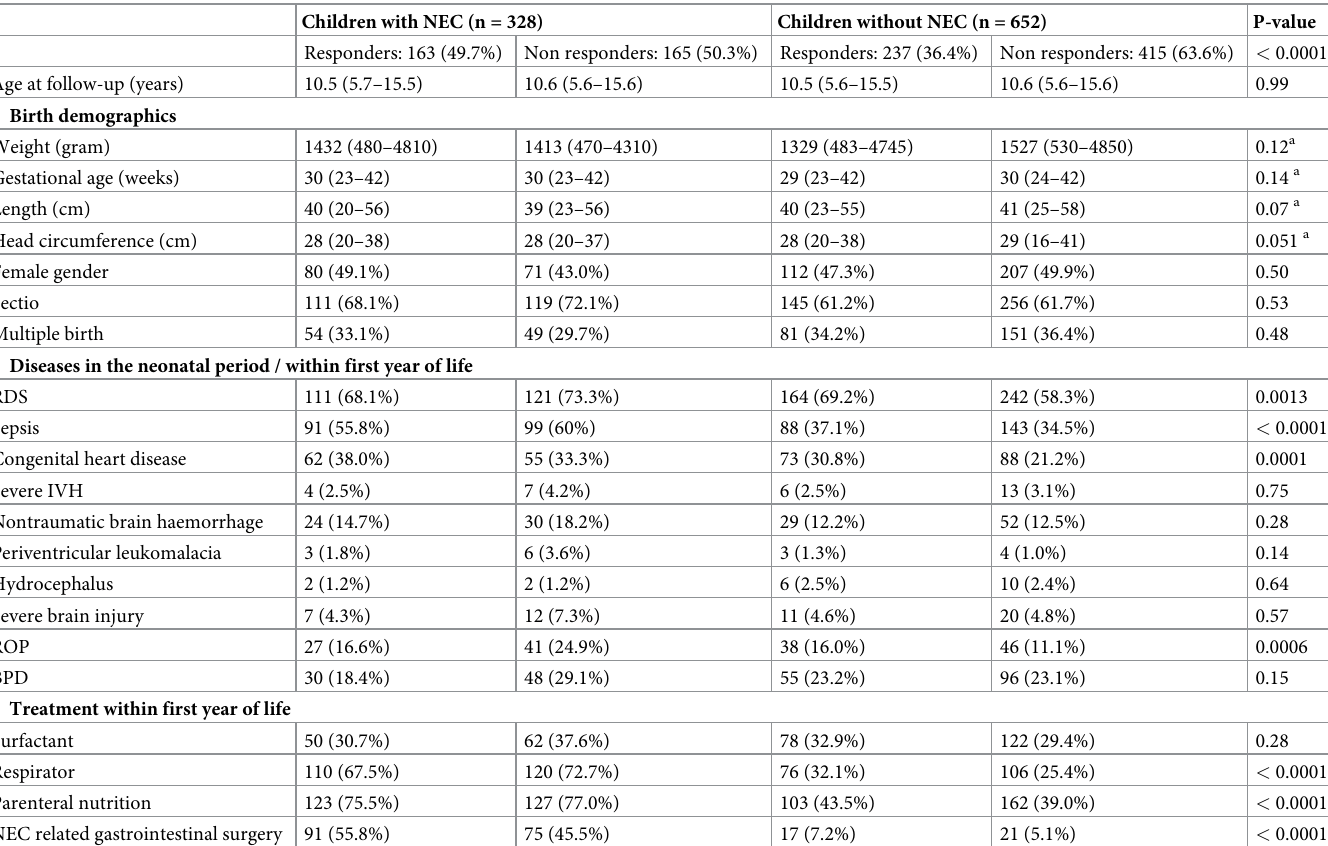
Table 3. Baseline characteristics for responders and non-responders in children with NEC and children without NEC.